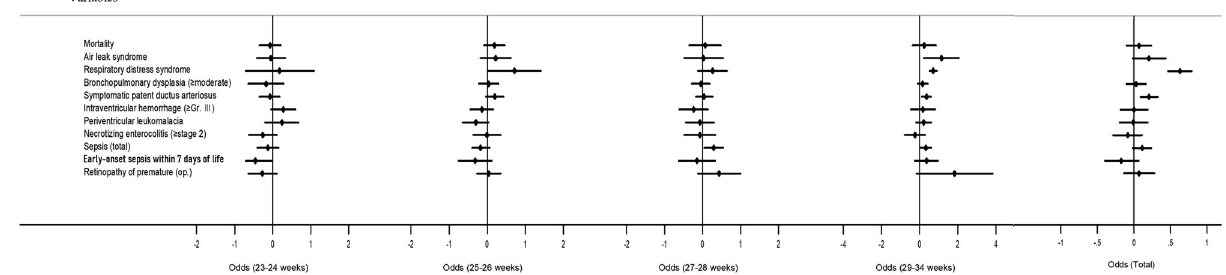
Figure 2. Adjusted odds ratios of mortality and morbidities associated with cesarean section (95% confidence